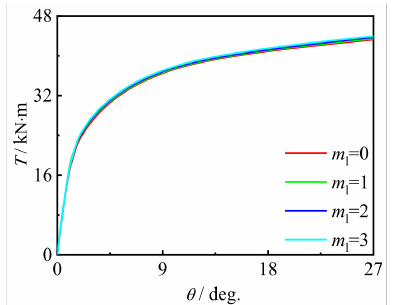
Figure 20. Effect of m l on T - θ curve.